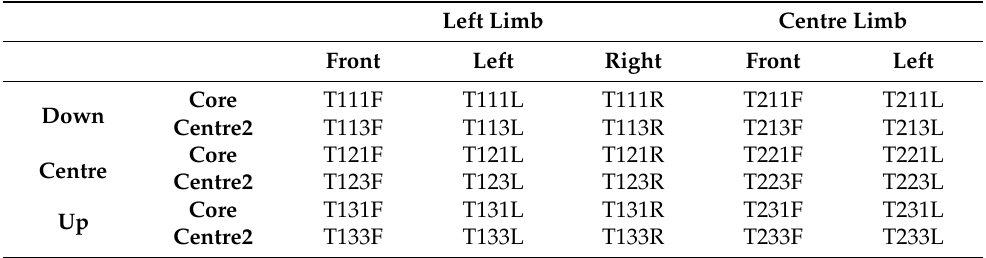
Table 2. Location of the thermocouples.